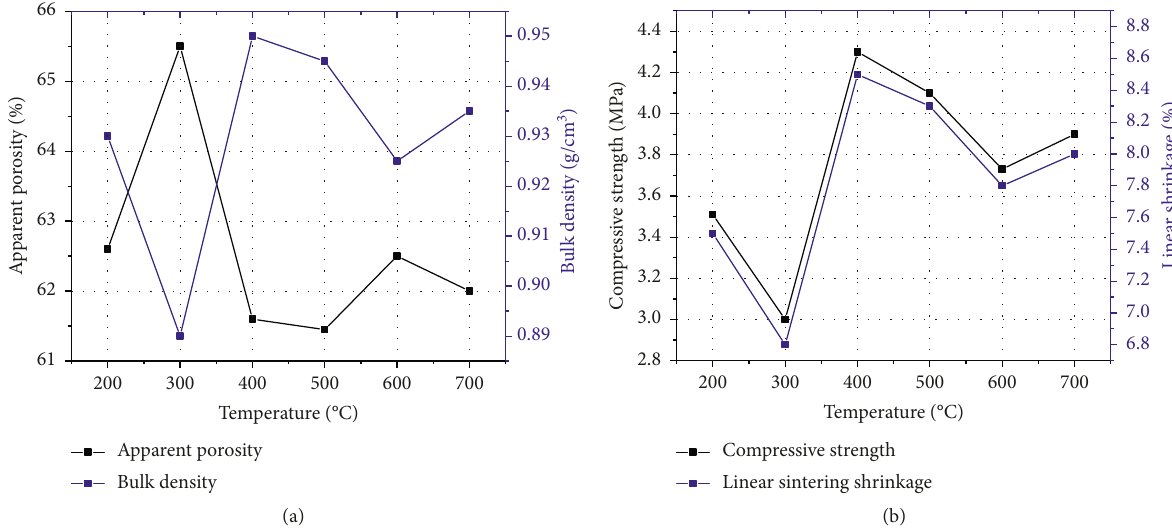
Figure 5: Influence of one-stage sintering process on (a) the apparent porosity and bulk density and (b) compressive strength and linear sintering shrinkage of the porous ceramics.